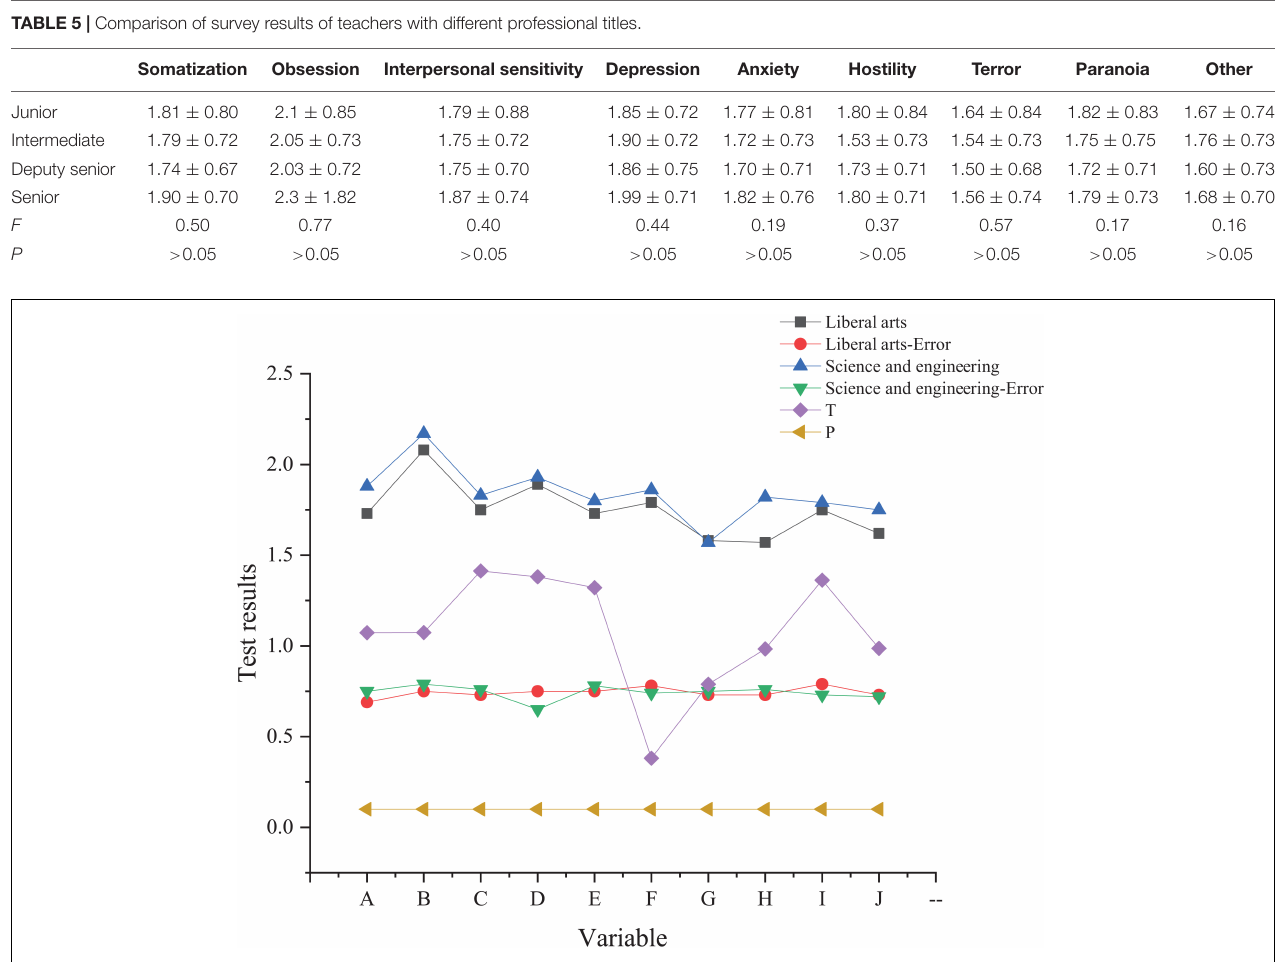
FIGURE 4 | Comparison of survey results of teachers in different